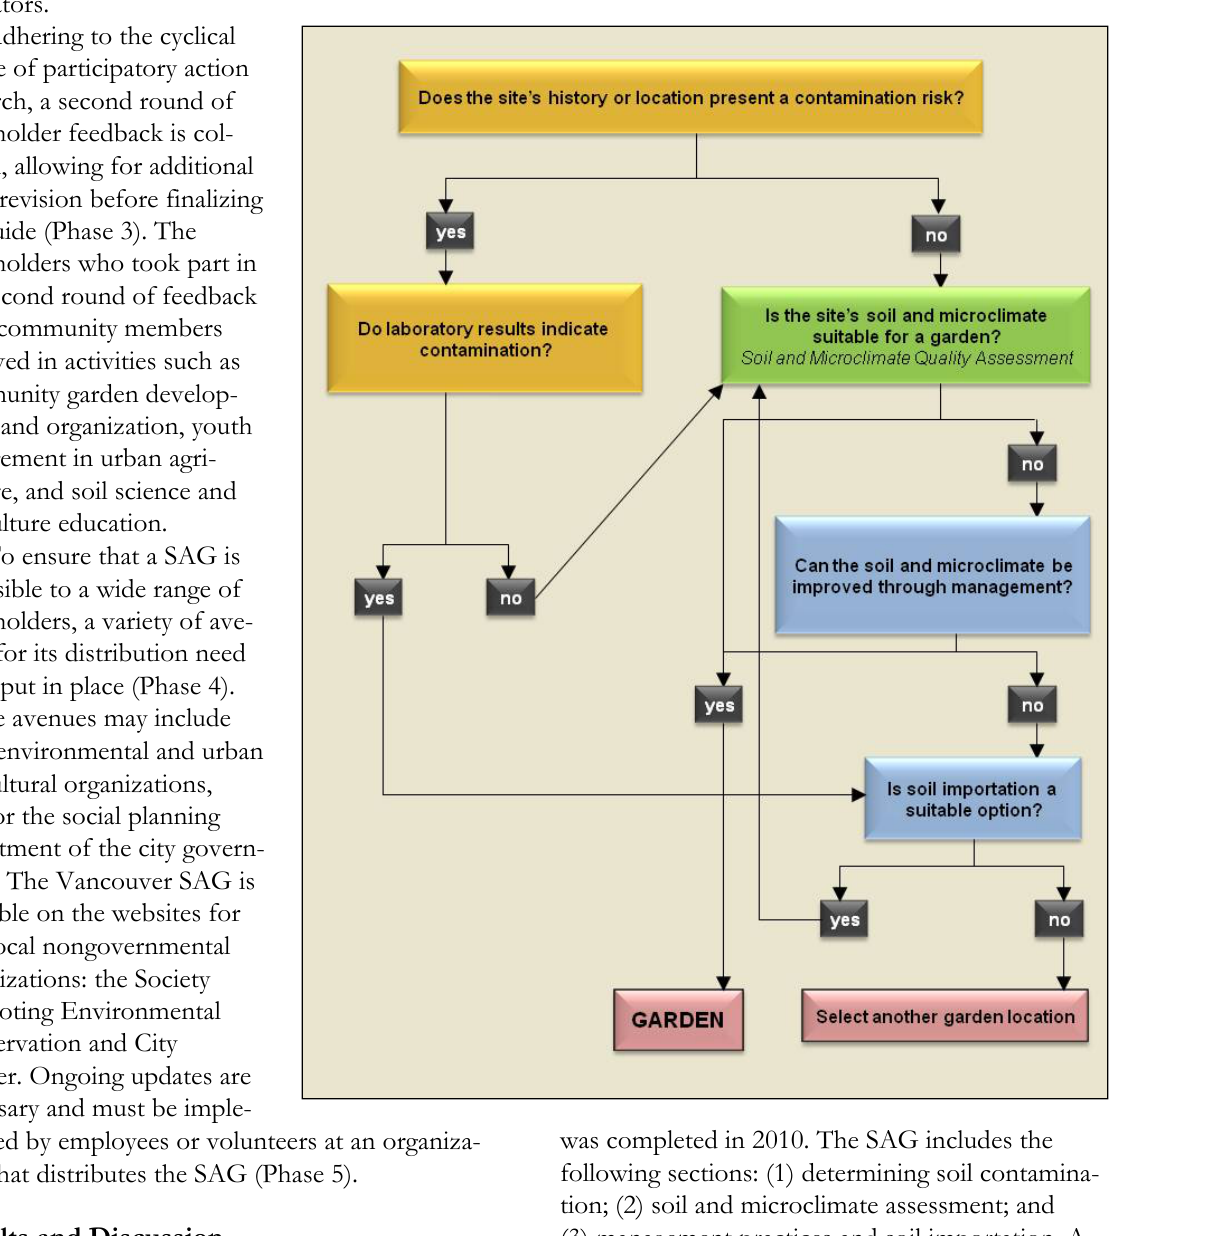
Figure 1. The Decision Tree from the Final Version of the Site Assessment Guide (SAG) for the City of Vancouver, British Columbia The chart is presented at the beginning of the SAG ( Starting a Community Garden: A Site Assessment Guide for Communities ) and is intended to guide users through the site assessment